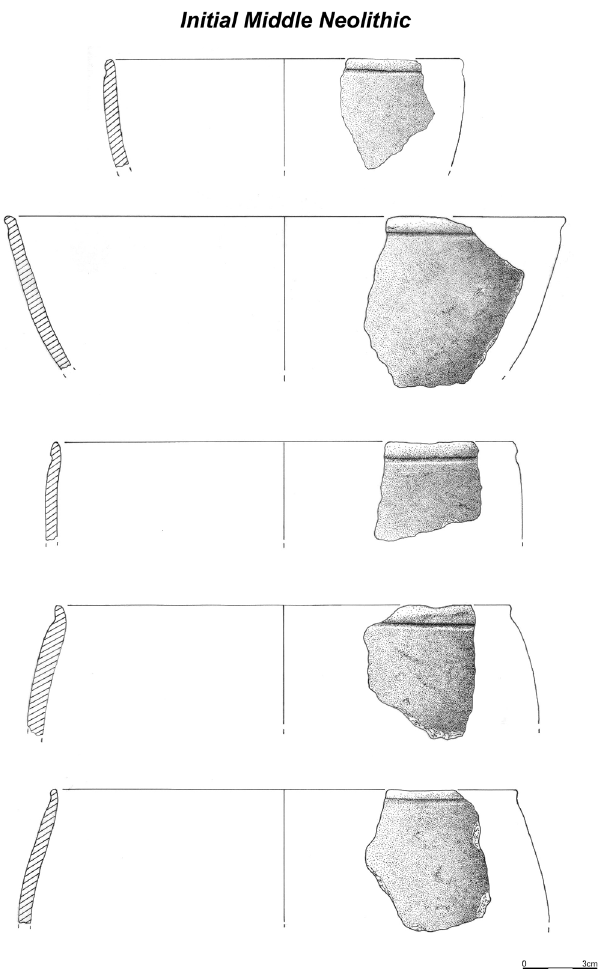
Figure 5: Evolved Early Neolithic ( ∼ 4500 – 3700 cal BC ) : Line below the rim from Monte da Foz ( adapted from: Neves, 2010 )